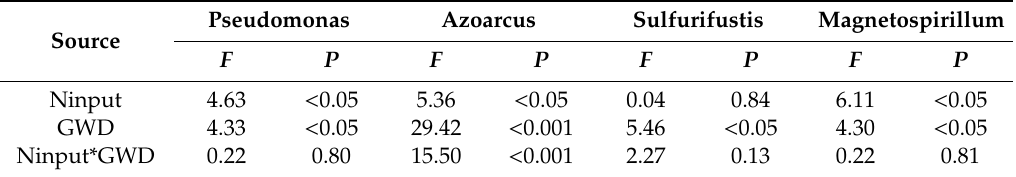
Table 3. E ff ects of depression of groundwater table, reduced nitrogen application and their interactions on the relative abundance of dominant genera in nir S-type denitrifier communities.